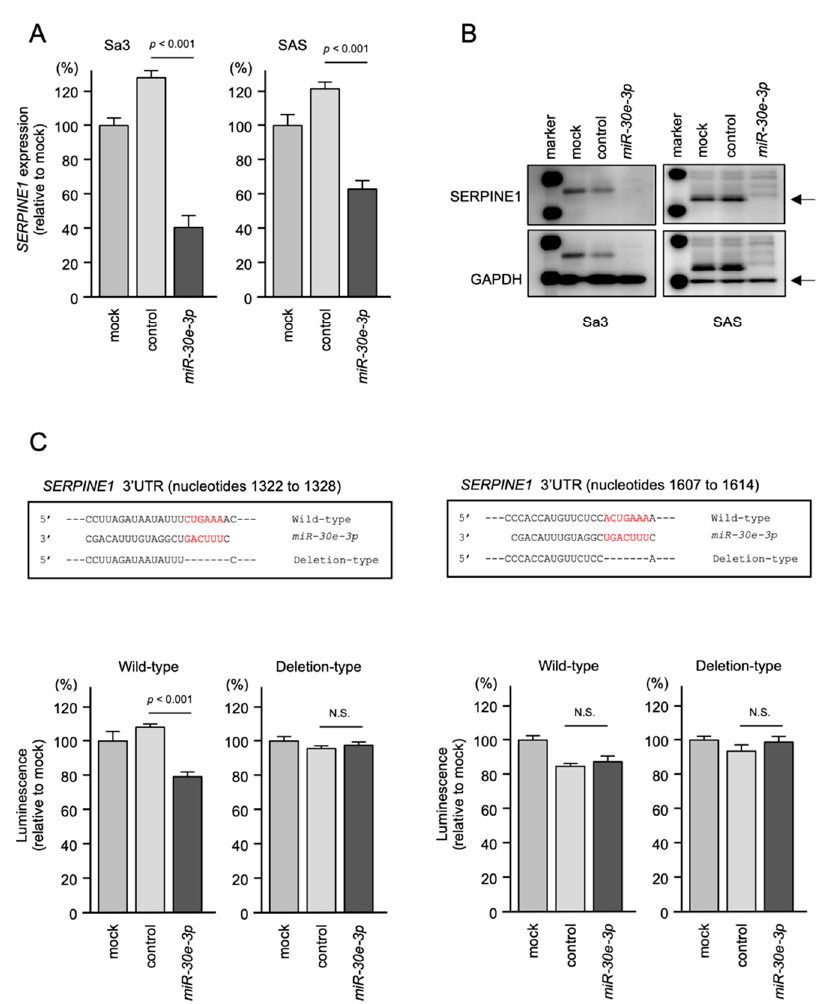
Figure 6. Direct regulation of SERPINE1 expression by miR-30e-3p in HNSCC cells. ( A ) qRT-PCR showing significantly reduced expression of SERPINE1 mRNA at 72 h after miR-30e-3p transfection in Sa3 and SAS cells. Expression of GAPDH was used as an internal control. ( B ) Western blot showing reduced expression of SERPINE1 protein at 72 h after miR-30e-3p transfection in Sa3 and SAS cells. Expression of GAPDH was used as an internal control. ( C ) TargetScan database analysis predicting two putative miR-30e-3p -binding sites in the 3 ′ -UTR of SERPINE1 (upper panel). Dual luciferase reporter assays showed reduced luminescence activity after co-transfection of the wild-type vector (position 1322–1328) and miR-30e-3p in Sa3 cells (left panel). There was no reduced luminescence activity after co-transfection of the deletion-type vector expressed as the Renilla/firefly luciferase activity ratio (N.S., not significant). For the